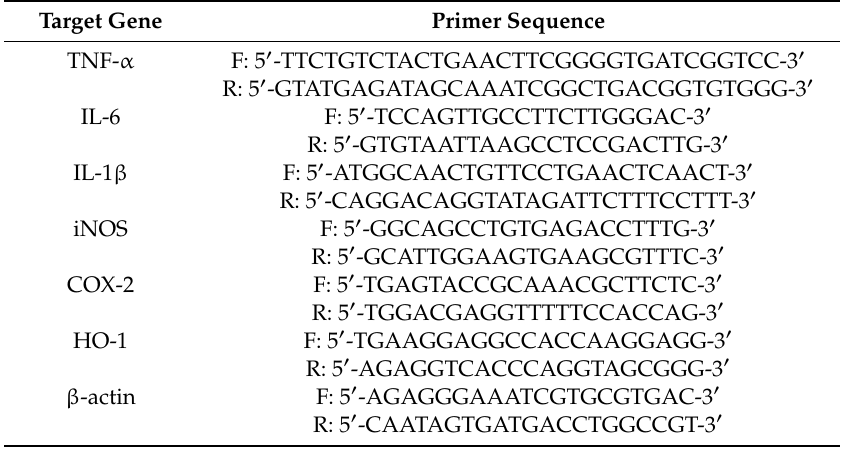
Table 3. Primers used for